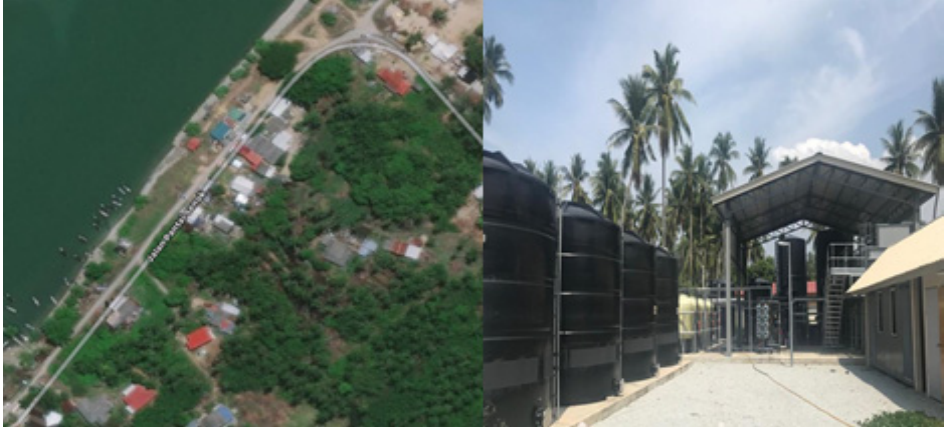
Figure 1. Map of seawater reverse osmosis (SWRO) desalination plant located in Kampung Pantai Senok, Kelantan.